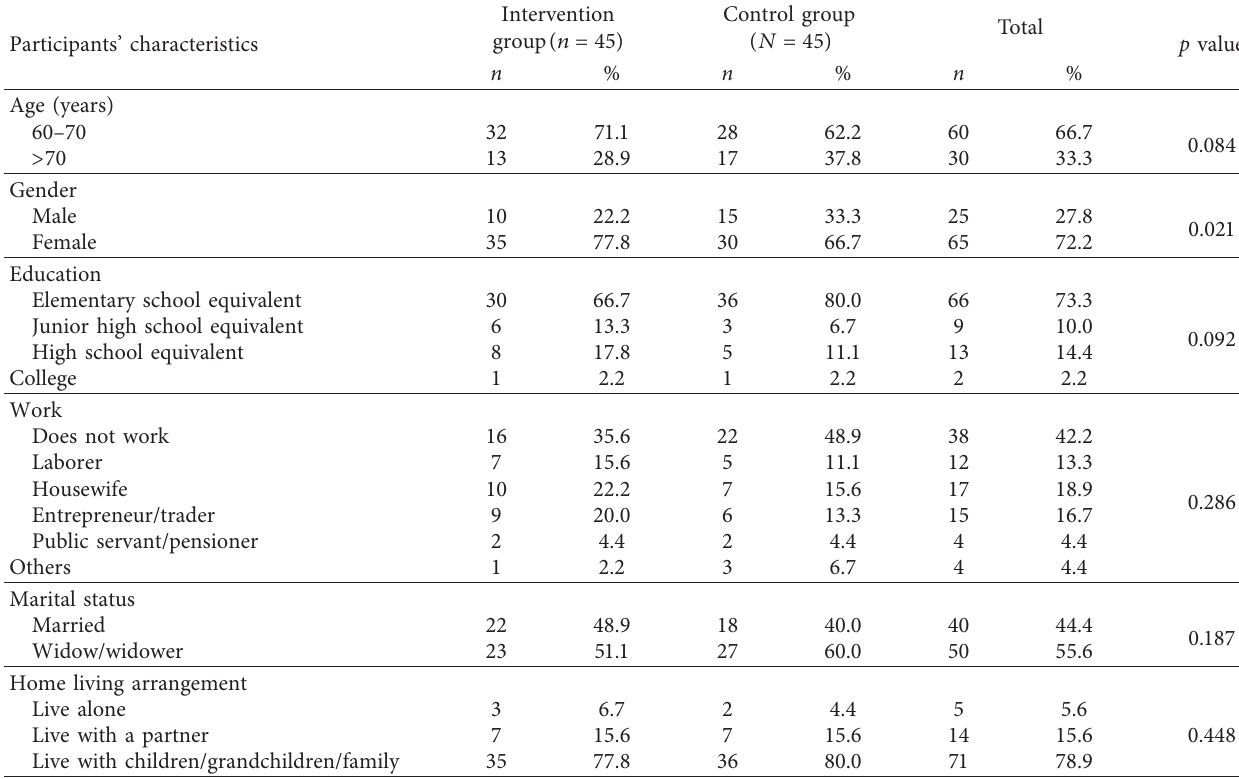
Table 3: Frequency distribution of participants’ characteristics and homogeneity results in the intervention group ( n � 45) and control group ( n � 45) in Dago Village Community Health Center working area.